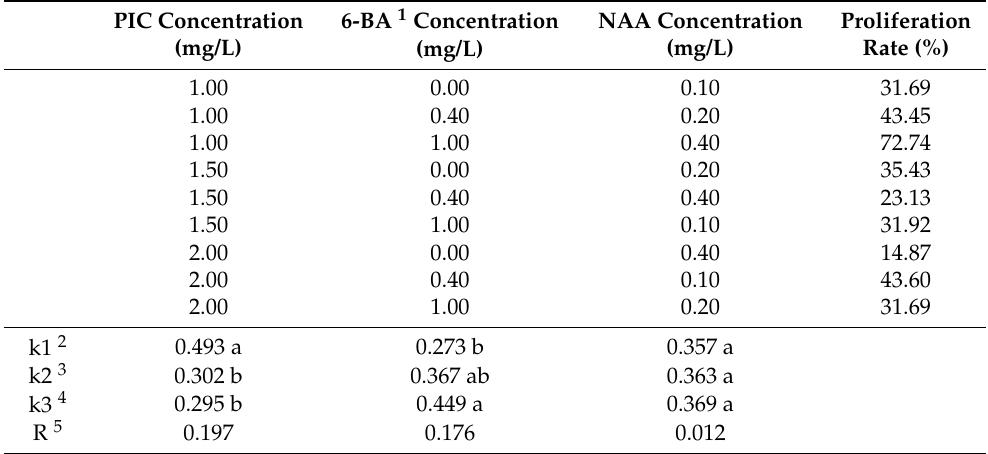
Table 4. Effects of different hormone combinations on proliferation of callus induced from A. praecox root explants.